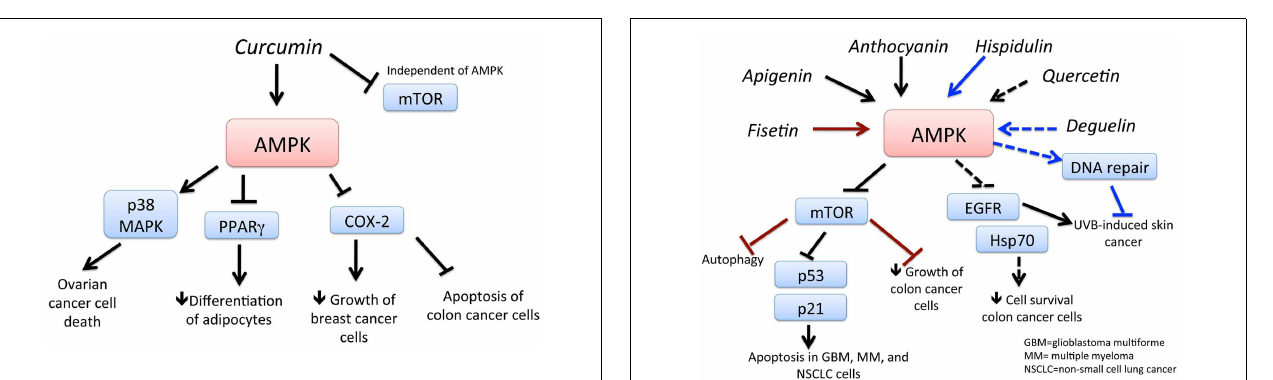
FIGURE 2 | Schematic representation ofAMPK-dependent anti-cancer effects of curcumin . Curcumin activates AMPK and increases cell death of ovarian cancer cells, in a p38 MAPK-dependent manner. Activation of AMPK by curcumin also leads to downregulation of PPAR g and COX-2, leading to decreased differentiation of adipocytes and delayed growth of breast cancer cells, respectively. Downregulation of COX-2 also leads to apoptosis of colon cancer cells. In addition, curcumin downregulates mTOR, independent of AMPK.